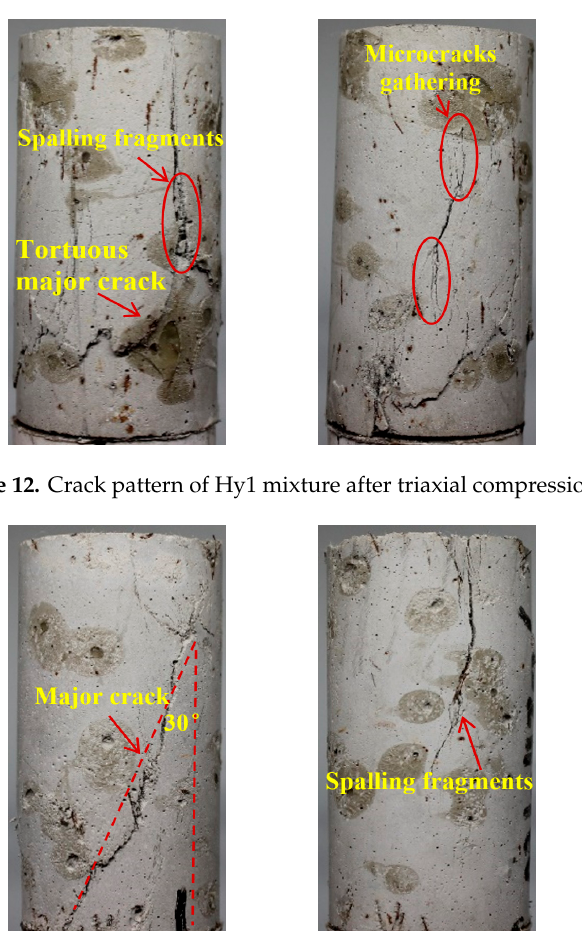
Figure 11. Crack pattern of Mono mixture after triaxial compression.